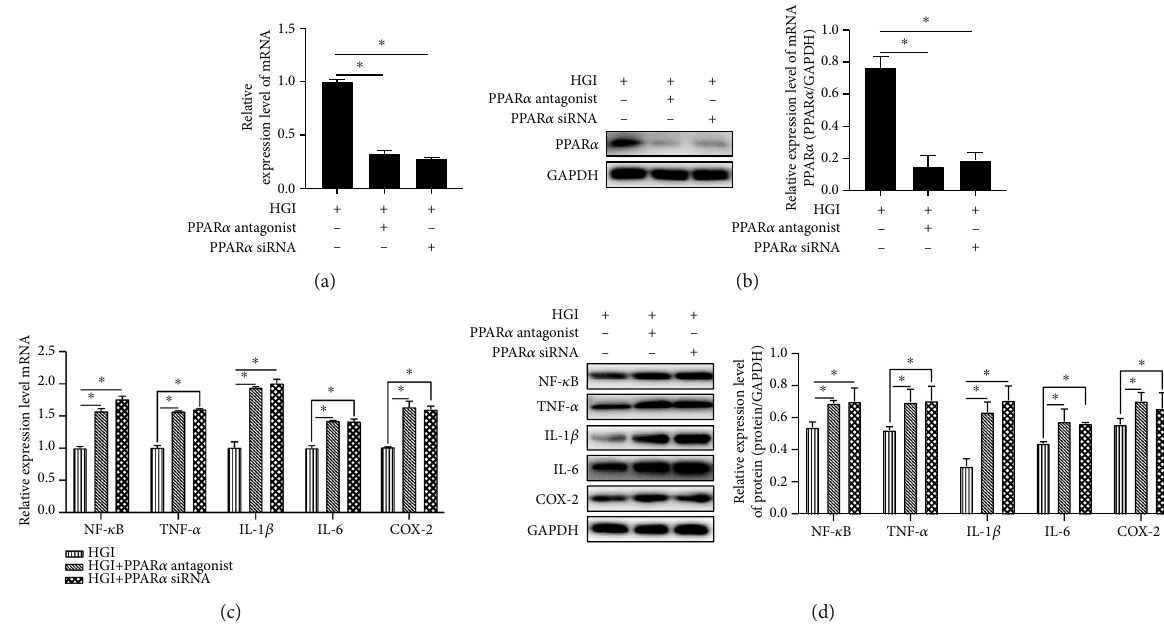
Figure 3: miR-518d negatively regulates PPAR α -mediated anti-in fl ammatory responses in HTR8/SVneo cells. Expression levels of PPAR α mRNA and protein were detected by (a) RT-PCR and (b) Western blotting. Expressions of mRNA and proteins of in fl ammatory factors were examined by (c) RT-PCT and (d) Western blotting, respectively. All data were represented as mean ± SD . ∗ p < 0 : 05